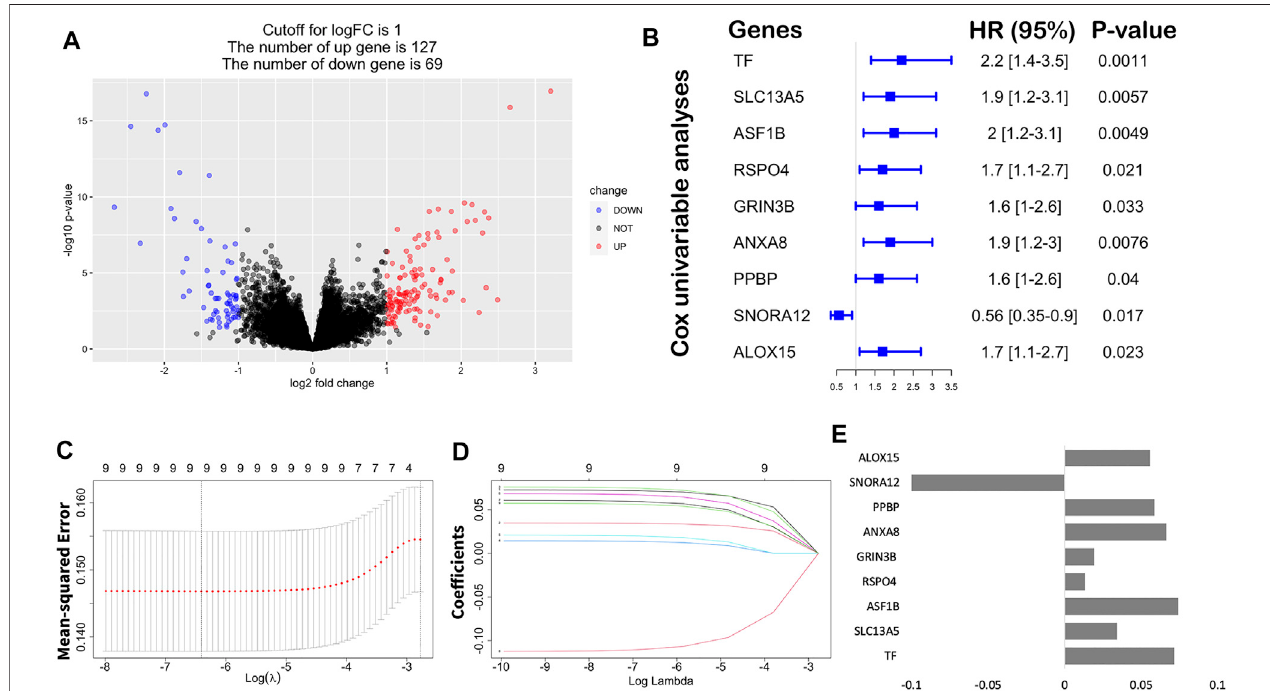
FIGURE6| Constructionoftheimmuneriskscoremodel. (A) Volcanoplotindicatedtheassociationbetweenlog2foldchangeand p -valueinDEGs,abs(log2FC) > 1 and p < 0.05. (B) Univariate analysis of nine signi fi cant genes with OS ( p < 0.05). (C) Correlation between log( λ ) and the mean-squared error in the LASSO Cox regressionmodel. (D) Correlationbetweenlog( λ )andthecoef fi cientsofrelevantintheLASSOCoxregressionmodel. (E) Coef fi cientsofeachindependentvariableinthe LASSO Cox regression model.